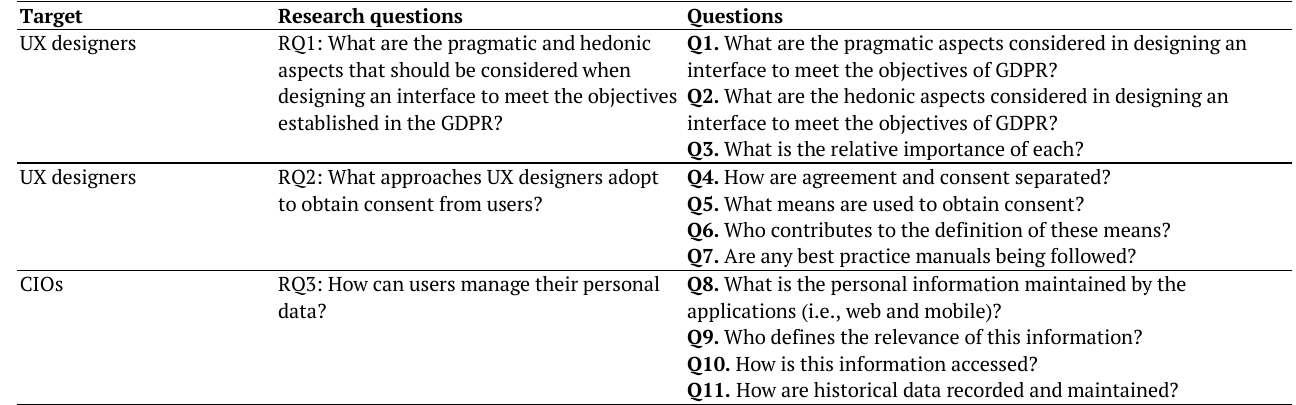
Table 1. Mapping research